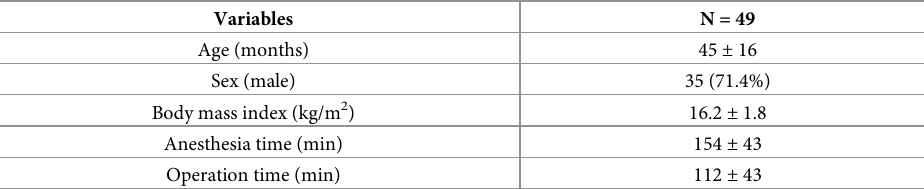
Table 1. Patient characteristics and surgical